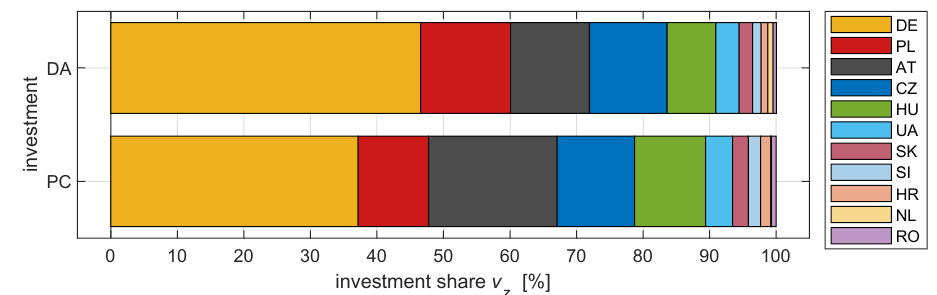
Figure 7. Investment shares ( v z ) for both locations of new PST (DA and PC)